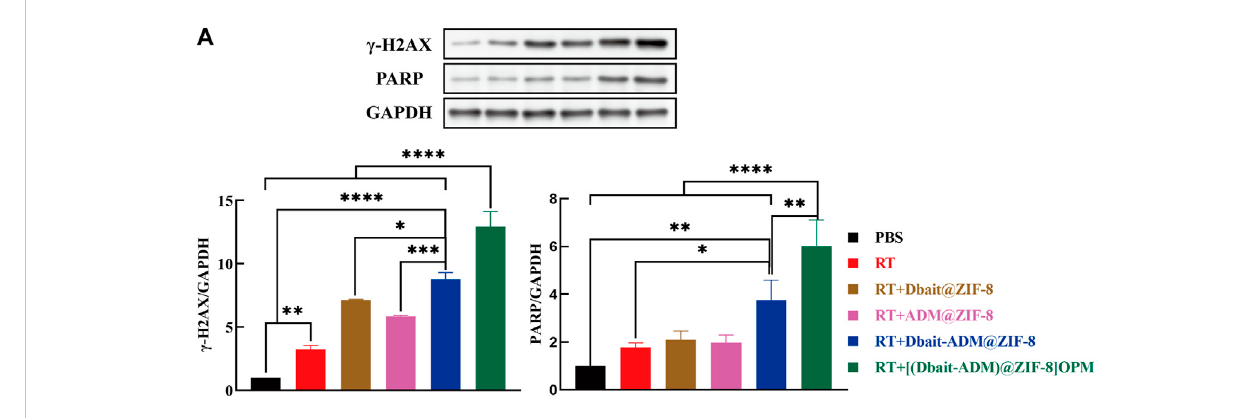
FIGURE 8 (A) Western blot analysis of γ -H2AX, PARP protein levels in OS